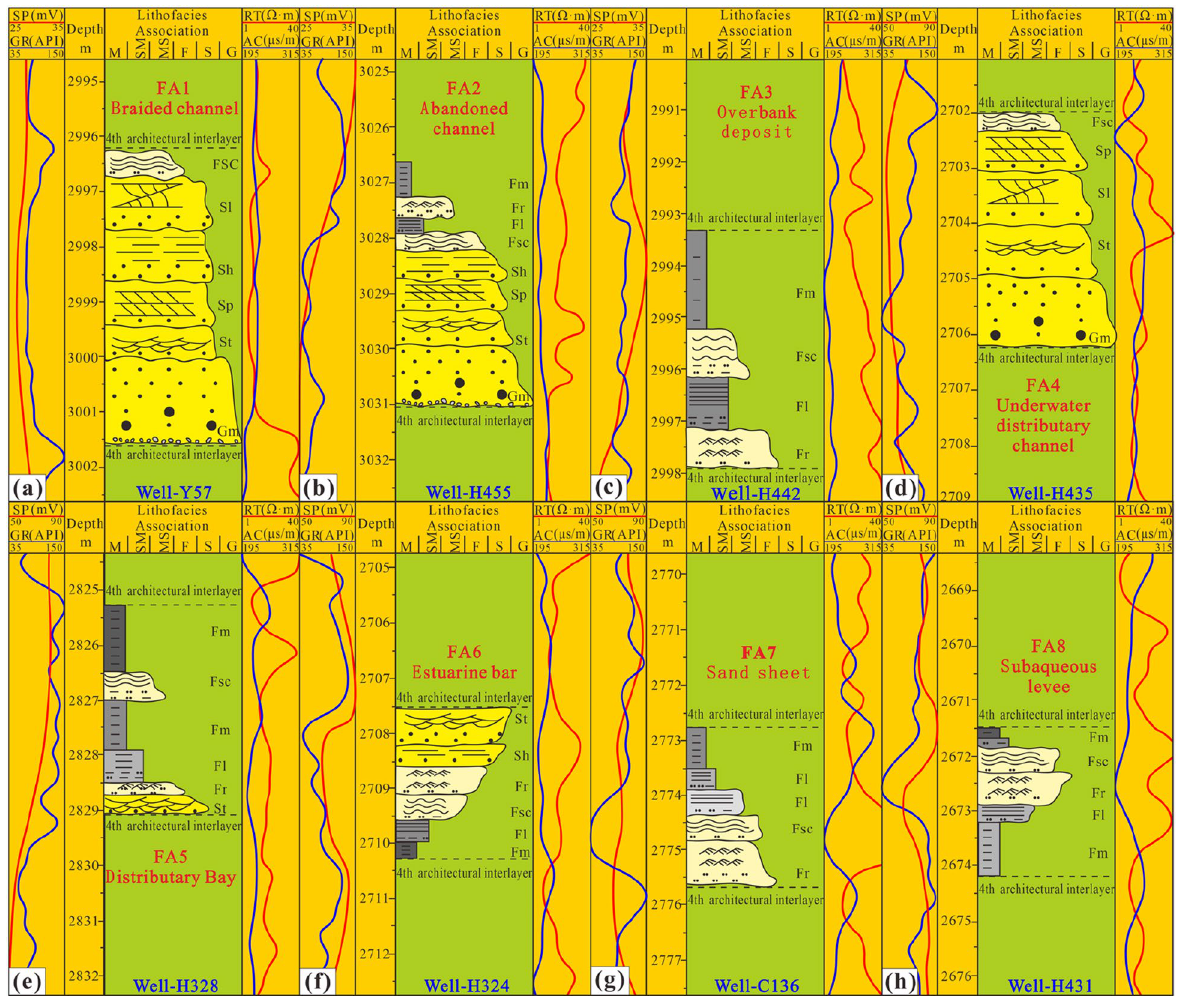
Figure 12. Eight FA types (architectural elements at the single sand body level) (Note: SP, GR, RT, AC are abbreviations of logging curve types and are consistent with the meanings in the above